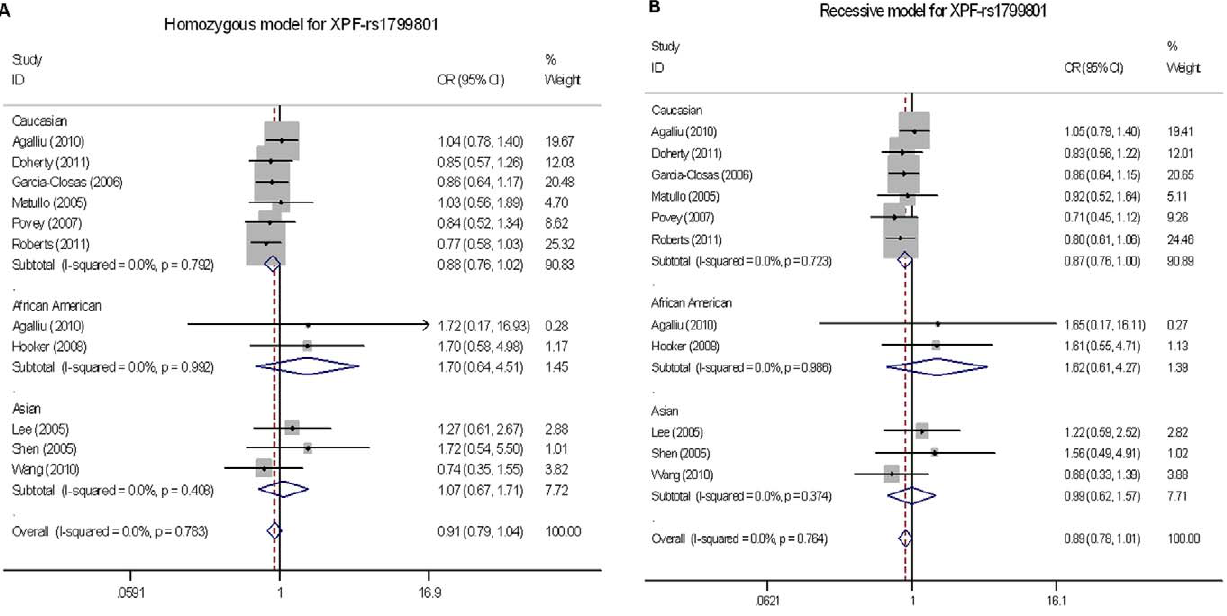
Figure 4. Forest plot of cancer risk associated with the XPF -rs1799801 polymorphism stratified by ethnicity. (A) CC vs. TT in a homozygous model and (B) CC vs. (CT + TT) in a recessive model by the fixed-effects for each of the 11 published studies. For each study, the estimates of OR and its 95% CI were plotted with a box and a horizontal line. The symbol filled diamond indicates pooled OR and its 95% CI. A significant association of the XPF -rs1799801 SNP with a borderline cancer risk in Caucasian populations was found (4845 cases and 5556 controls; recessive model: OR=0.87, 95% CI=0.76–1.00, P =0.049, P =0.723 for heterogeneity test, I 2 =0).